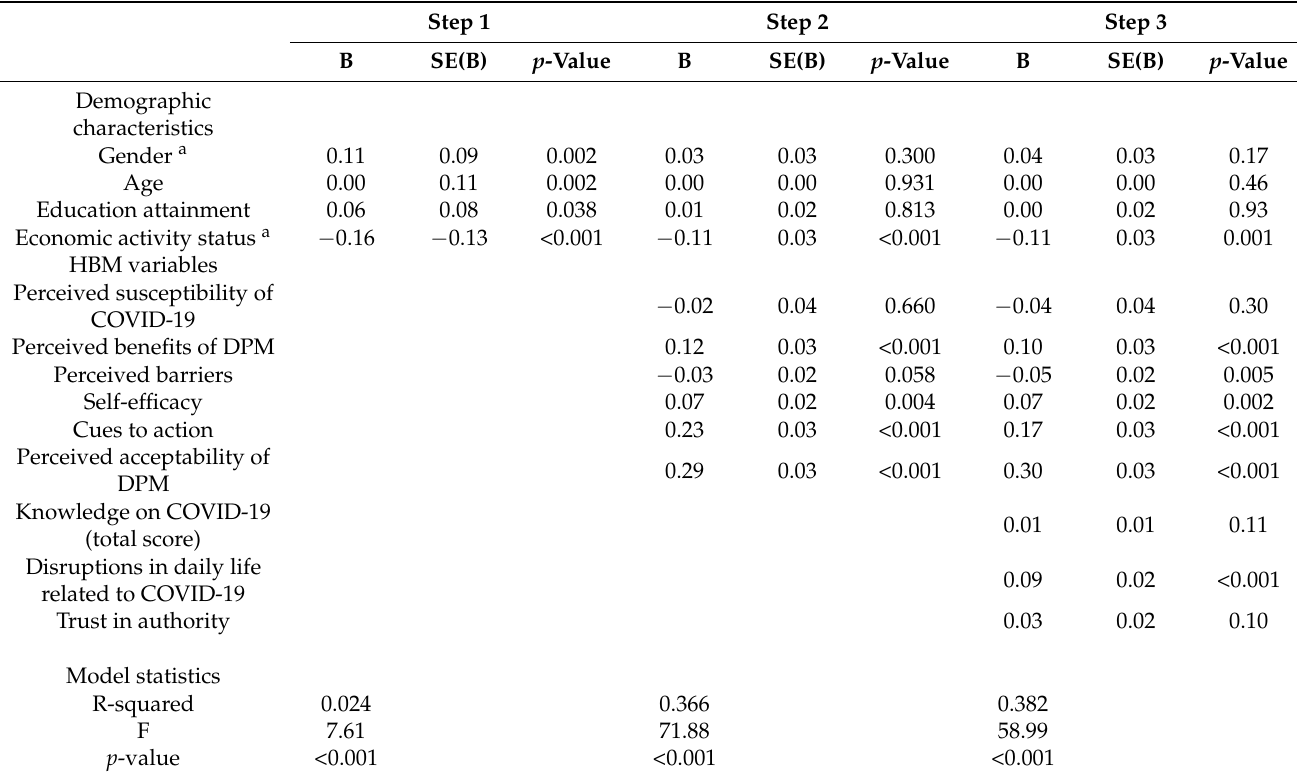
Table 4. Hierarchical multiple regression model predicting adherence to DPM among study participants ( N =